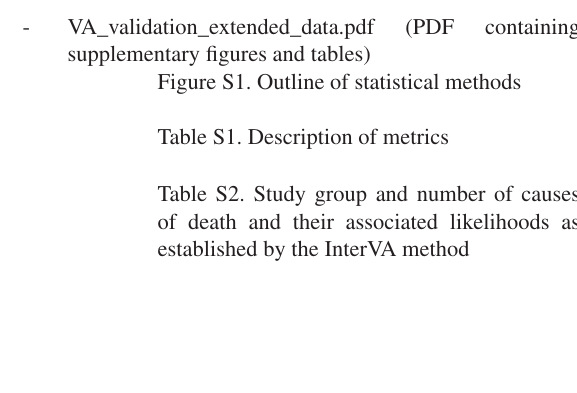
Table S3. Number of cases and